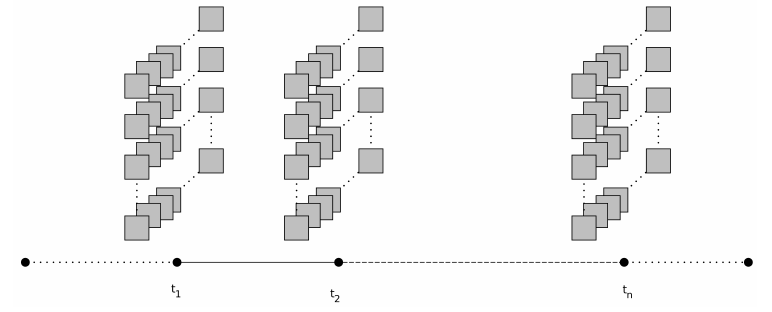
Figure 6. Observations for equal time intervals.